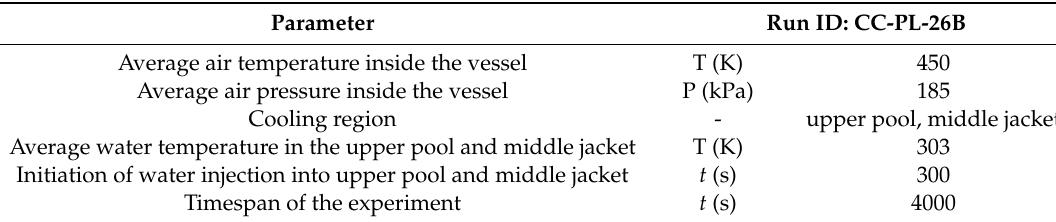
Table 1. Experimental